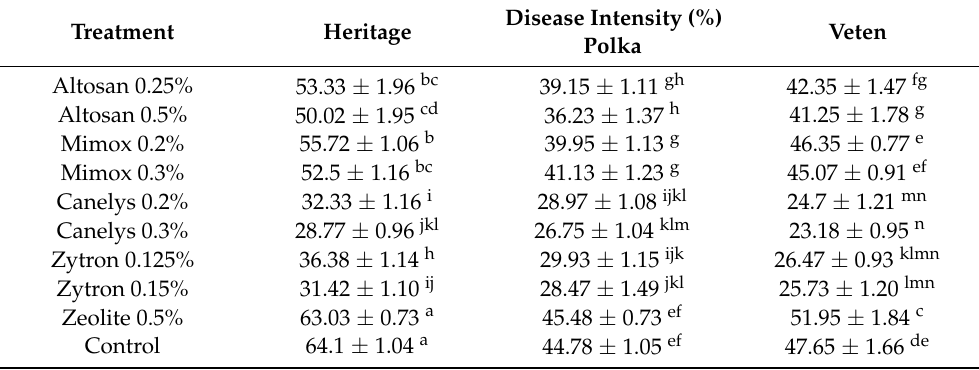
Note: Values presented in the table are the means ± standard error. Means followed by different letters indicate differences at p < 0.05 according to LSD test applied to all varieties from each species. Variants tested: V1-Altosan 0.25%; V2-Altosan 0.5%; V3-Mimox 0.2%; V4-Mimox 0.3%; V5-Canelys 0.2%; V6-Canelys 0.3%; V7-Zytron 0.125%; V8-Zytron 0.15%; 9-Zeolite 0.5%; V10-Control. A full description of treatment recipes is provided in Table